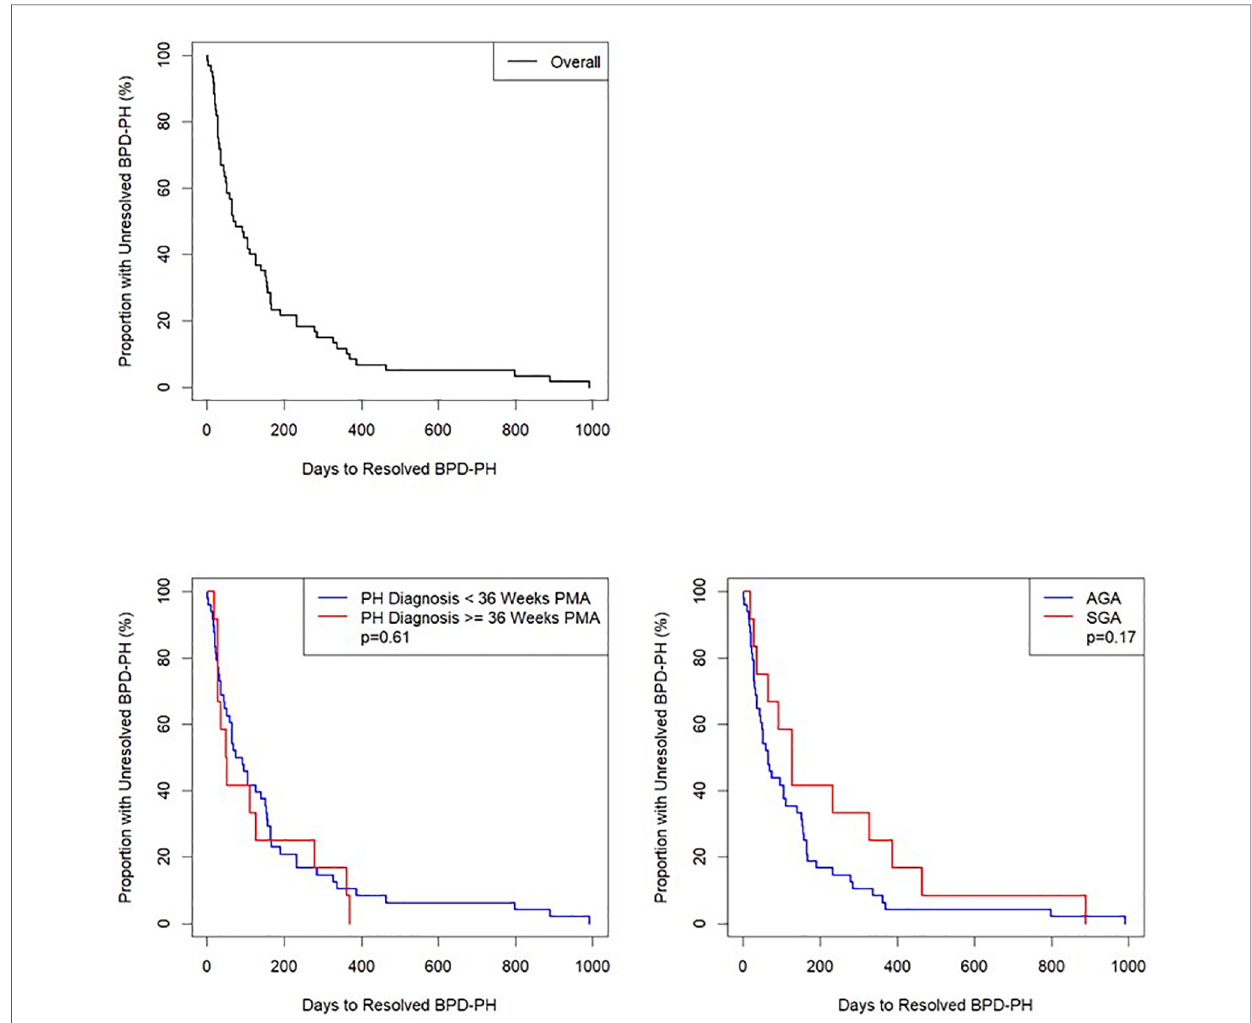
FIGURE 2 Kaplan – Meier curve of number of days from diagnosis to resolution of bronchopulmonary dysplasia-pulmonary hypertension (BPD-PH), n =60. Top Left: entire cohort; Bottom Left: divided by BPD-PH diagnosed<or ≥ 36 weeks postmenstrual age (PMA); Bottom Right: divided by small for gestational age (SGA) or appropriate for gestational age (AGA). Log rank tests were calculated with signi fi cance de fi ned as p